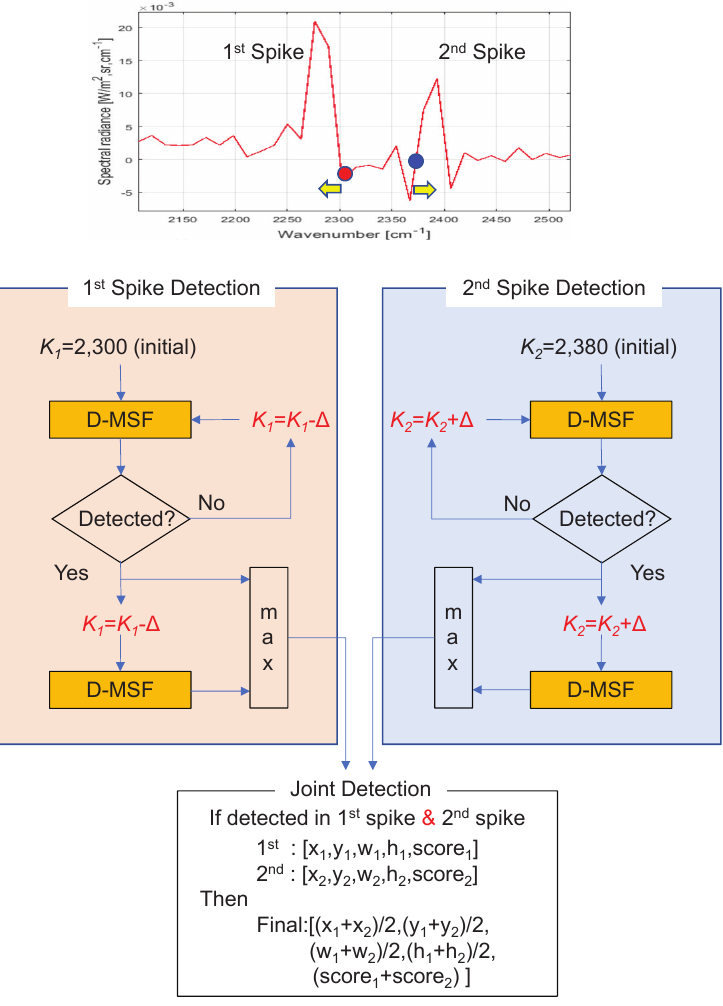
Figure 5. Details of the proposed CO 2 -DS: first spike detection, second spike detection, and joint